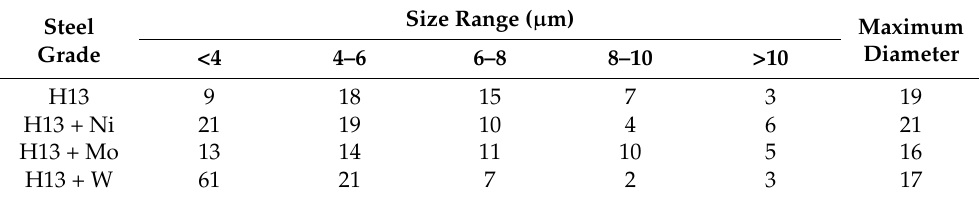
Table 8. Number and size of the inclusions in electroslag ingots (area: 1.5 × 1.5 cm).